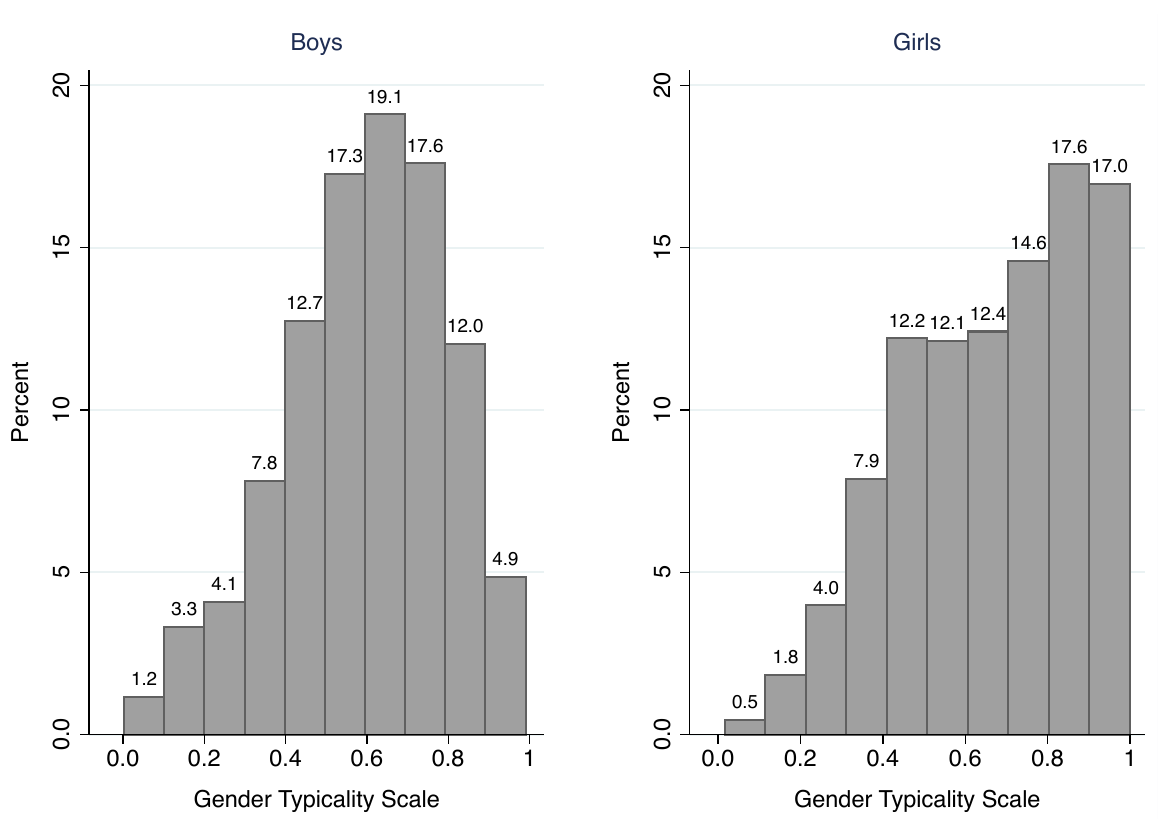
Figure 1: Percentage of high school students across the gender typicality scale. behaviors. Differences are most notable between black and Asian boys. Based on numerical counts (not shown), about 58 percent of black boys score in the gender- typical range above 0.60—in contrast to the scores of Asian boys of which 46 percent are in this range. Nearly one-quarter of Asian boys have gender-atypical scores lower than 0.40, but only 13 percent of black and 16 percent of white boys score in this range. The percentages of white and Hispanic boys who score in the gender- typical range (53 percent and 50 percent, respectively) fall in between those of black and Asian boys. Figure 2 shows a bimodal distribution for girls, in which gender typicality scores